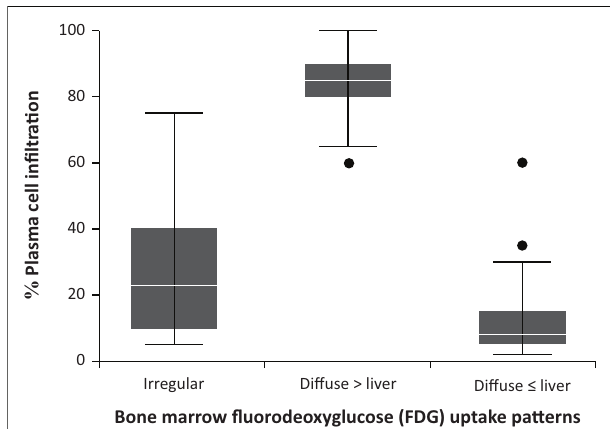
FIGURE 1: A box plot showing median and interquartile percentage of bone marrow plasma cell infiltration for the three patterns of 18 F-FDG